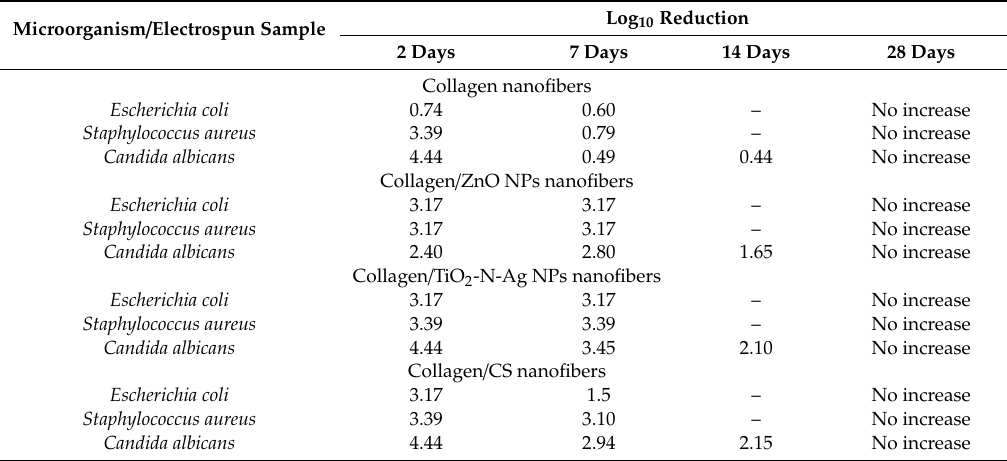
Table 5. Log 10 reduction in the number of viable microorganisms against the value obtained for the inoculums for collagen-based